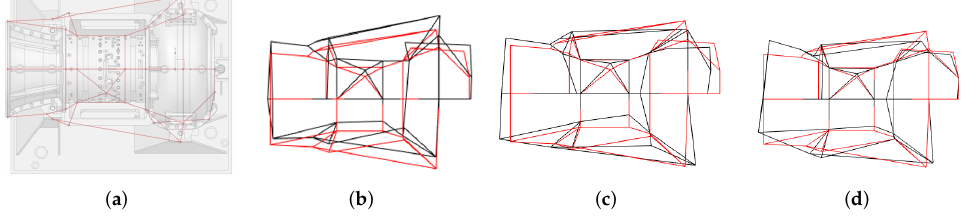
Figure 5. ( a ) Compressor with grid lines from mode shape animation: ( b ) 64 Hz; ( c ) 107 Hz; ( d ) 133 Hz. First three mode shapes gained from EMA of casing with rotor at